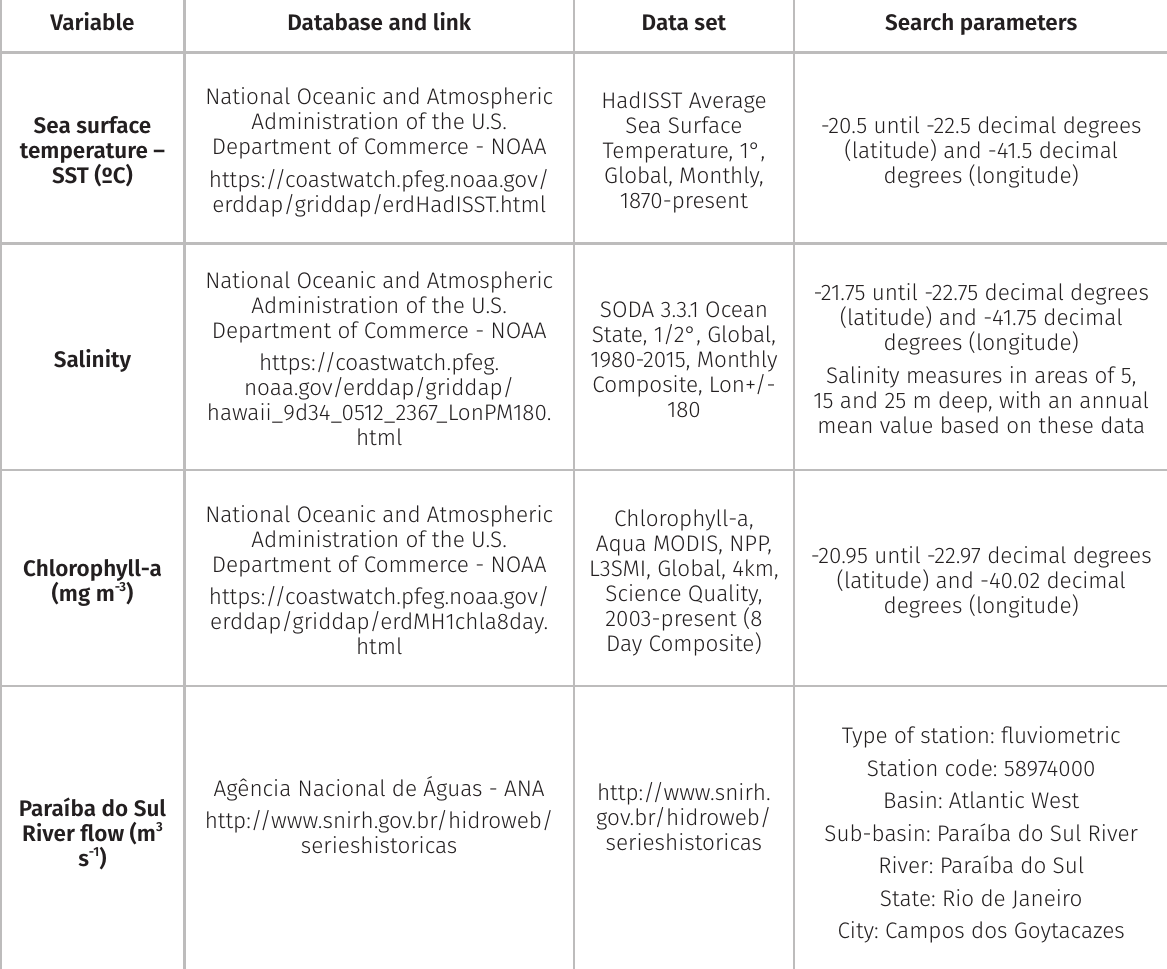
Table I. Parameters to search for the environmental variables in the fishing area from 2005 to 2013. Variable Database and link Data set Search